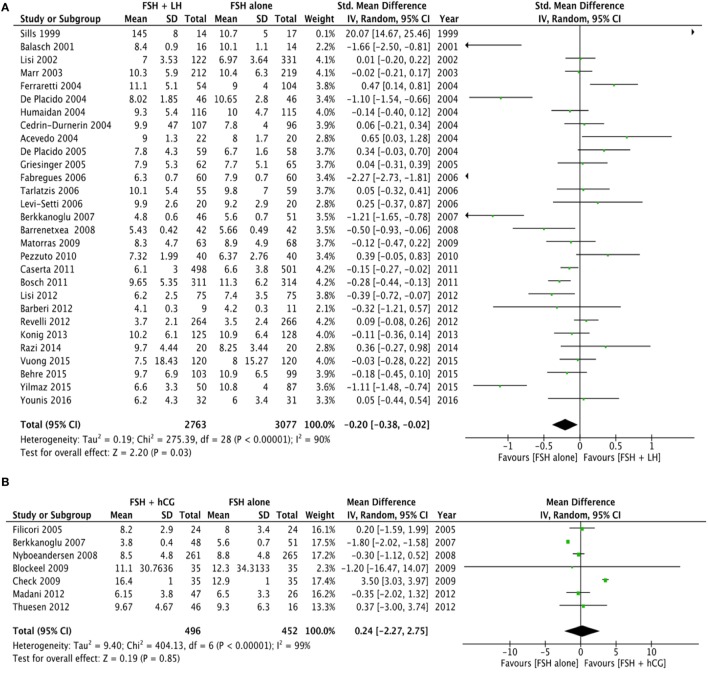
Forrest plot evaluating the retrieved oocytes number comparing follicle-stimulating hormone alone to luteinizing hormone (A), human chorionic gonadotropin (B), and human menopausal gonadotropin (C).